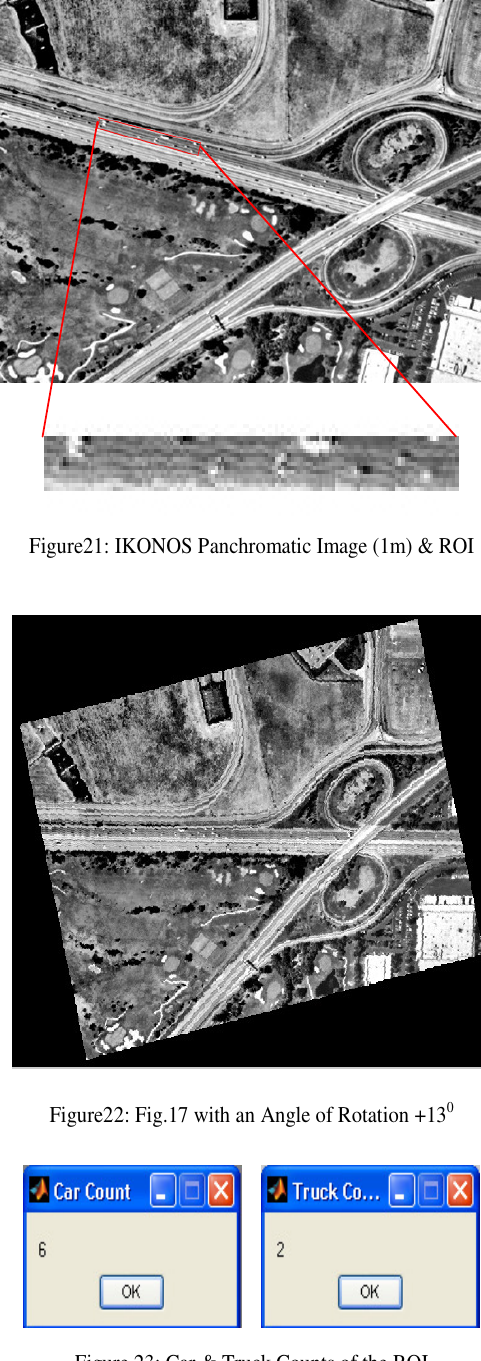
Figure 23: Car & Truck Counts of the